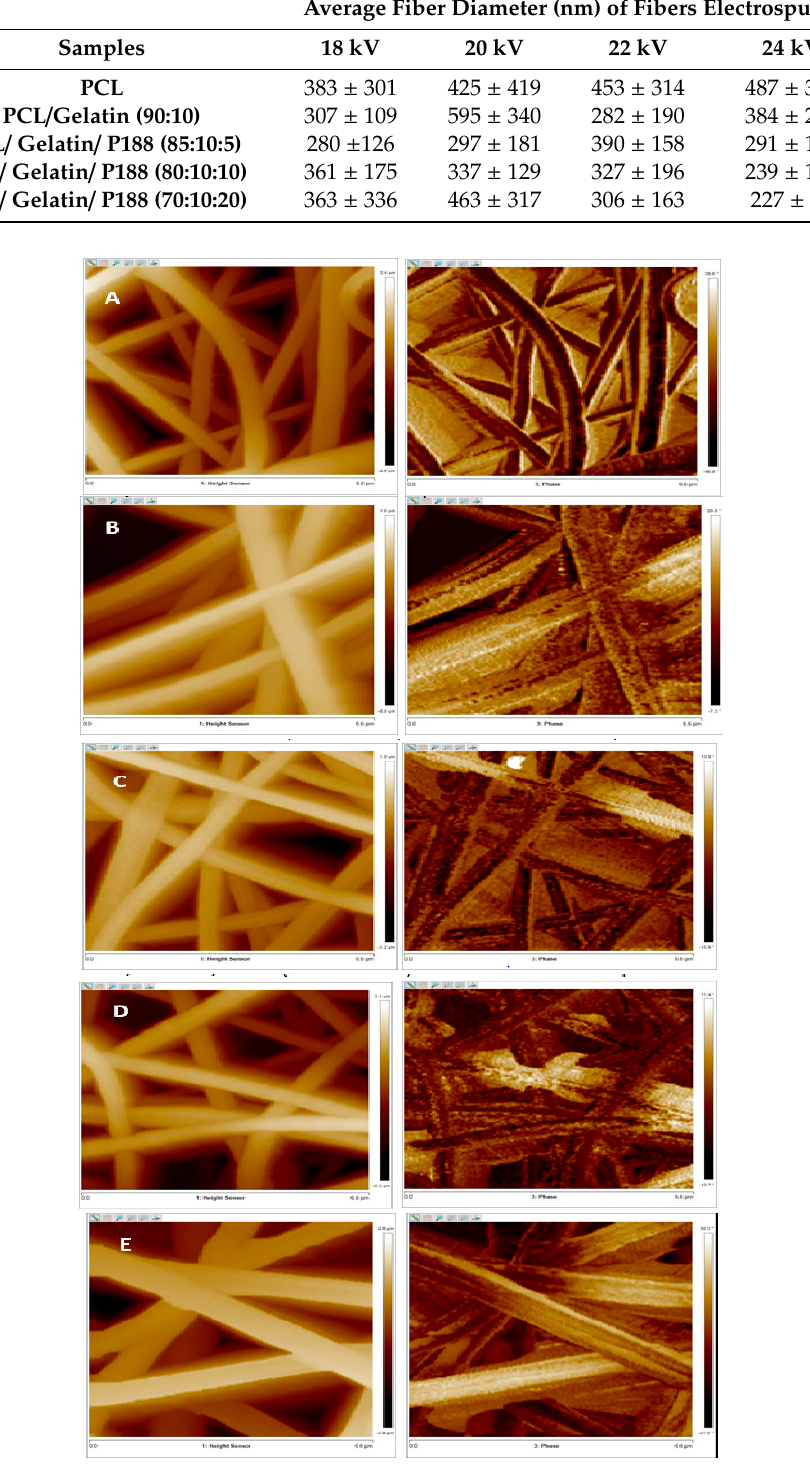
Figure 6. The height and phase AFM images of ( A ) PCL, ( B ) PCL/gelatin, ( C ) PCL/gelatin/P188 of concentration 85:10:5 %w/v, ( D ) PCL/gelatin/P188 of concentration 80:10:10 %w/v, and ( E ) concentration 85:10:5 %w / v, ( D ) PCL / gelatin / P188 of concentration 80:10:10 %w / v, and ( E ) PCL / gelatin / P188 PCL/gelatin/P188 of concentration 70:10:20 %w/v electrospun at 22 kV along with the (the scanning of concentration 70:10:20 %w / v electrospun at 22 kV along with the (the scanning area was 6.6 µ m to 6.6 µ